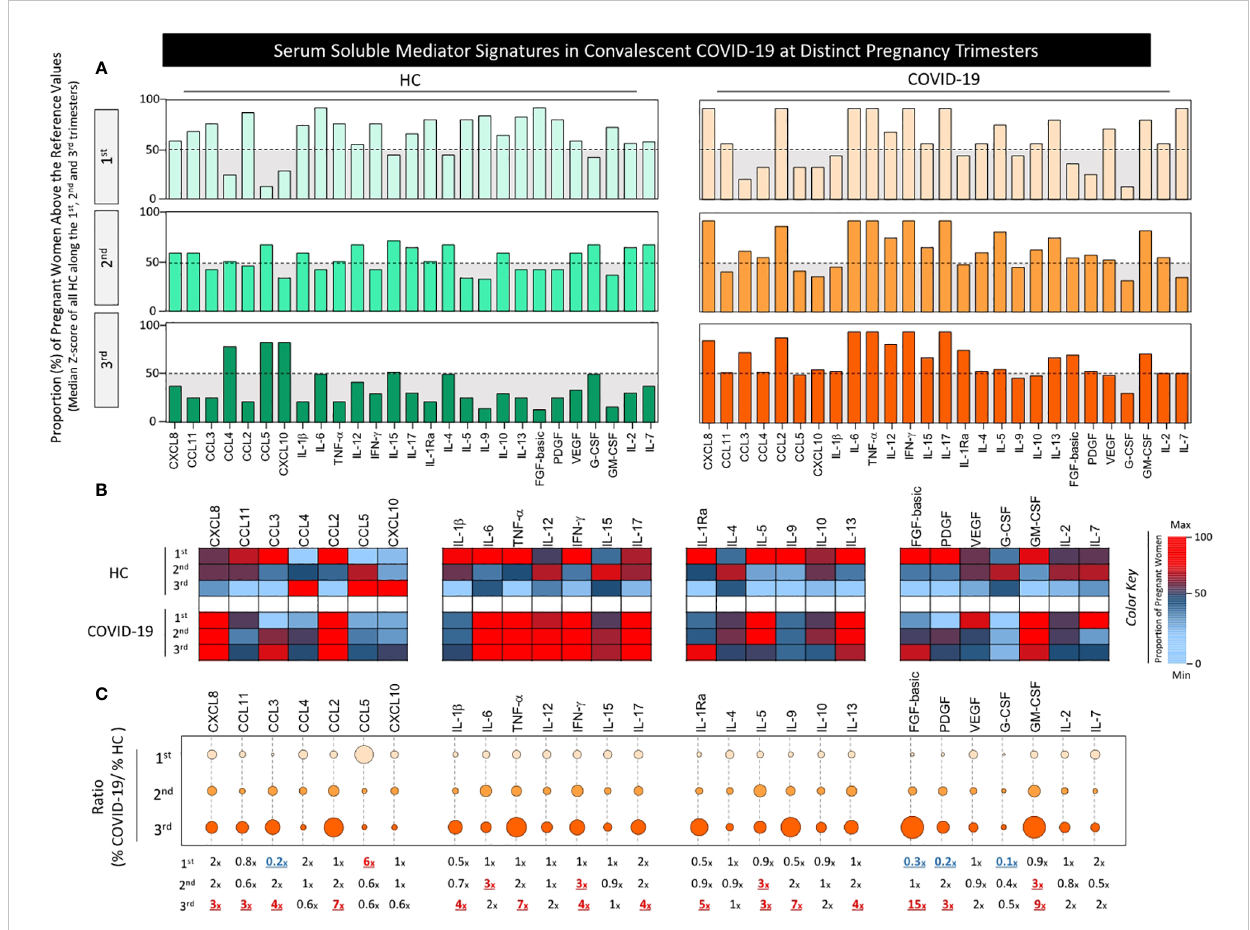
FIGURE 3 Serum soluble mediator signatures in convalescent COVID-19 patients at distinct pregnancy trimesters. Signatures of: serum chemokines (CXCL8, CCL11, CCL3, CCL4, CCL2, CCL5, and CXCL10), pro-in fl ammatory cytokines (IL-1 b , IL-6, TNF- a , IL-12, IFN- g , IL-15, and IL-17), regulatory cytokines (IL-1Ra, IL-4, IL-5, IL-9, IL-10, and IL-13), and growth factors (FGF-basic, PDGF, VEGF, G-CSF, GM-CSF, IL-2, and IL-7) were assembled for pregnant women with convalescent COVID-19 at 3-20 weeks after symptoms onset (COVID, n=89) and for pre-pandemic non-infected pregnant women as a Healthy Control (HC, n=52). The HC and COVID-19 groups were further categorized into subgroups according to pregnancy trimester, referred to as: HC 1 st ( , n=21), HC 2 nd ( , n=10), HC 3 rd ( , n=21) and COVID 1 st ( , n=7), COVID 2 nd ( , n=34), COVID 3 rd ( , n=48). The measurements were taken by high-throughput multiplex bead array as described in Material and Methods. (A) The results are presented in bar charts showing the proportion (%) of pregnant women with serum levels above the reference values (cut-off) de fi ned as the median Z-score of each soluble mediator detected for all HC along the 1 st , 2 nd and 3 rd trimesters, as described in Material and Methods. The serum soluble mediators displaying a proportion of pregnant women above 50% (grey zone, dashed line) were included in the set of biomarkers with increased levels. (B) Heatmap constructs were further assembled to illustrate the overall pro fi le of serum soluble mediator signatures of COVID and HC subgroups along the pregnancy trimesters. A color key was used to underscore the serum soluble mediators with decreased (proportion <50%, towards light blue), unaltered (proportion =50%, black) or increased levels (proportion>50%, towards red). (C) The ratio between the proportion of pregnant women with serum levels above the reference values in the COVID group in relation to HC (%COVID/%HC) was further calculated and presented in orbital graphs. The ratios of each serum soluble mediator along the 1 st , 2 nd and 3 rd trimesters are provided in the fi gure, underscored as decreased ( ≤ 0.3x, blue), unaltered (0.4-2x, black) or increased ( ≥ 3x,